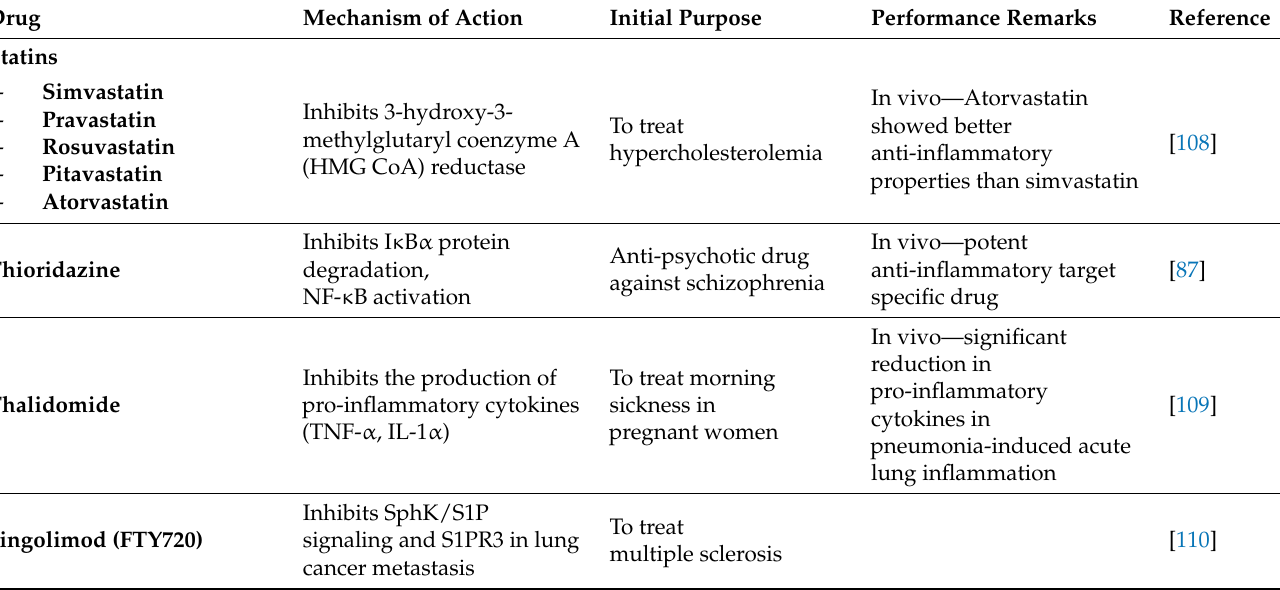
Table 2. List of existing drugs with anti-inflammation properties for NSCLC